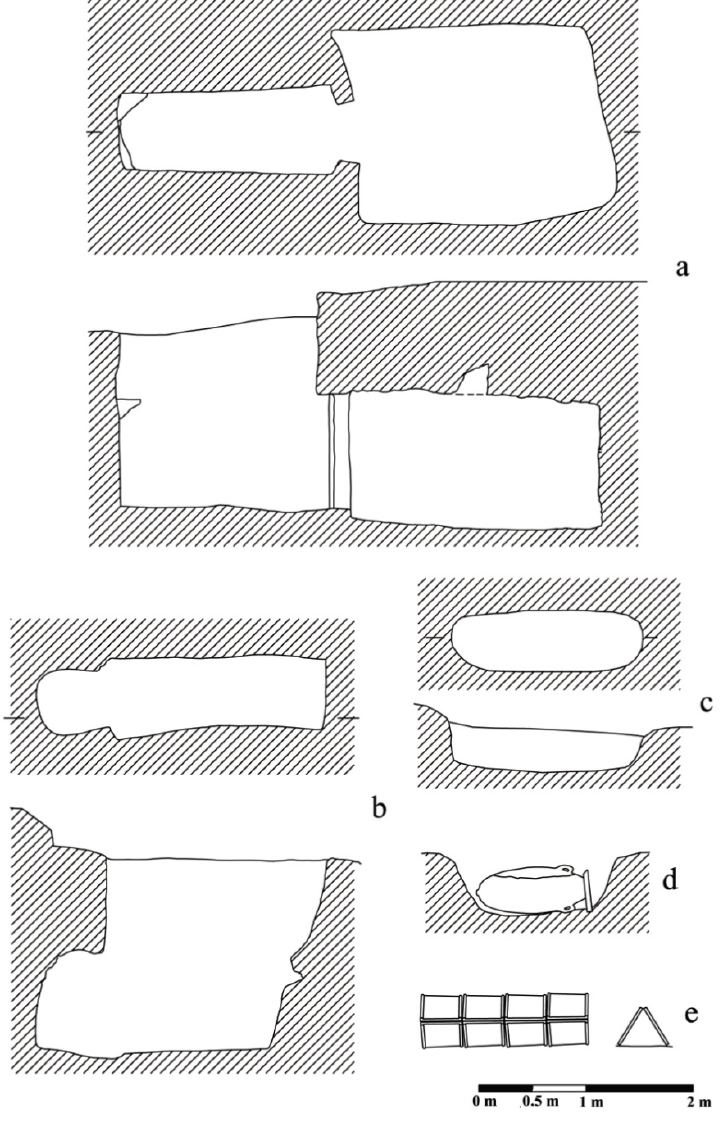
a stone cist, with the plan and cross-section; ( c ) tomb in a pit, with the plan and cross-section; ( d ) tomb in an enchytrismós , with the cross-section; ( e ) tomb at the “capuchin”, with the plan and